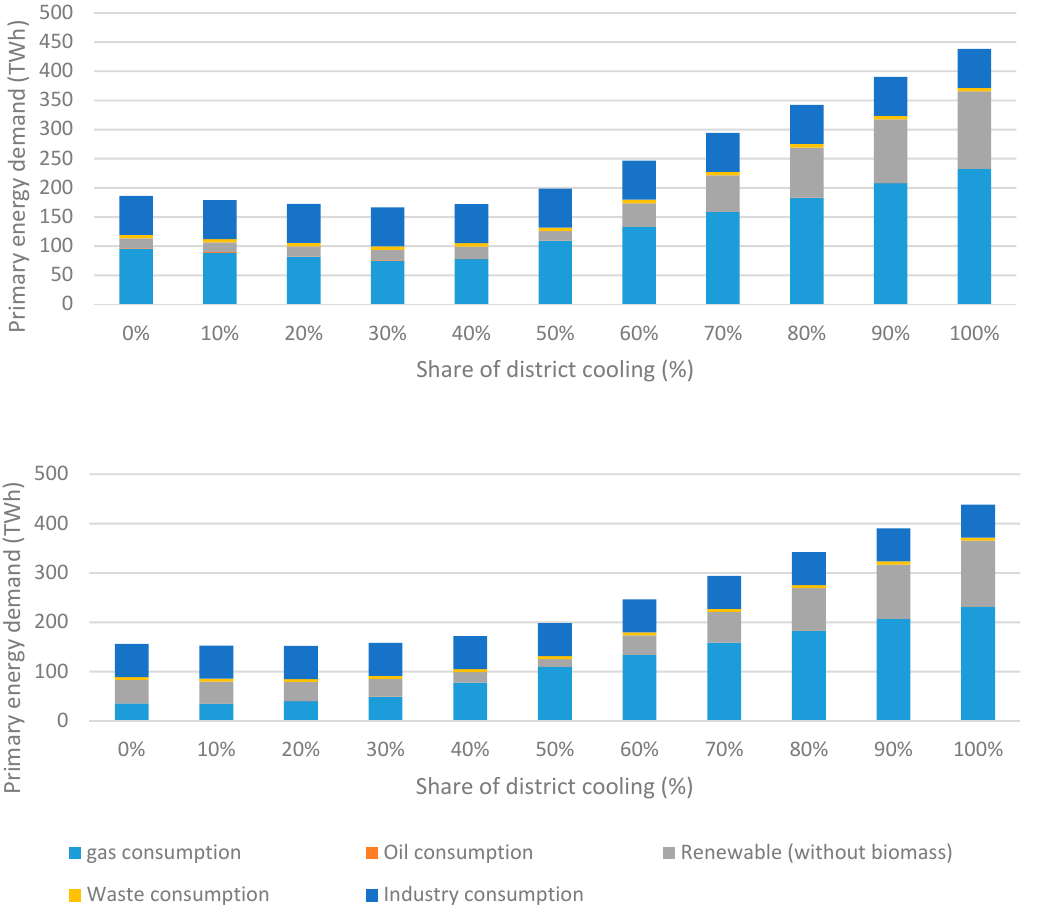
Figure 2. Total primary energy demand in PV constrained ( Top ) and unconstrained PV scenarios ( Bottom ).